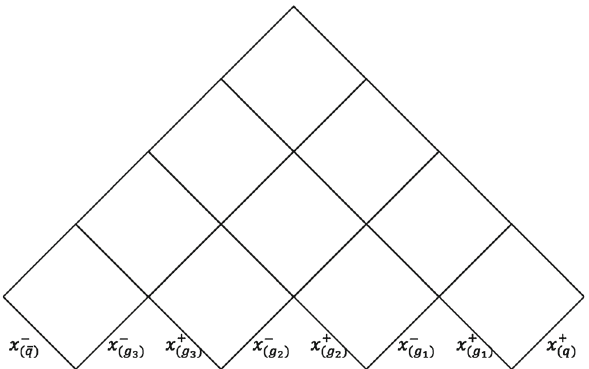
Fig. 8 Theparameterplanepictureforamultipartonsystemcomposed by five